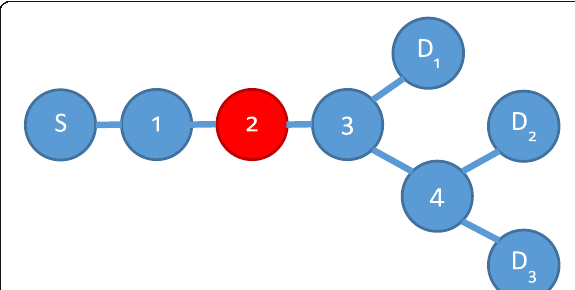
Fig. 3 Network topology used in the simulation with a source node (S) and three destinations ( D 1 , D 2, and D 3 ). In the simulation, all nodes forward 100% of the packets, except node 2 that forwards only a 70% of the packets during the first half of the simulation. Afterwards, the node changes its behavior and forwards a 90% of the packets during the last half of the